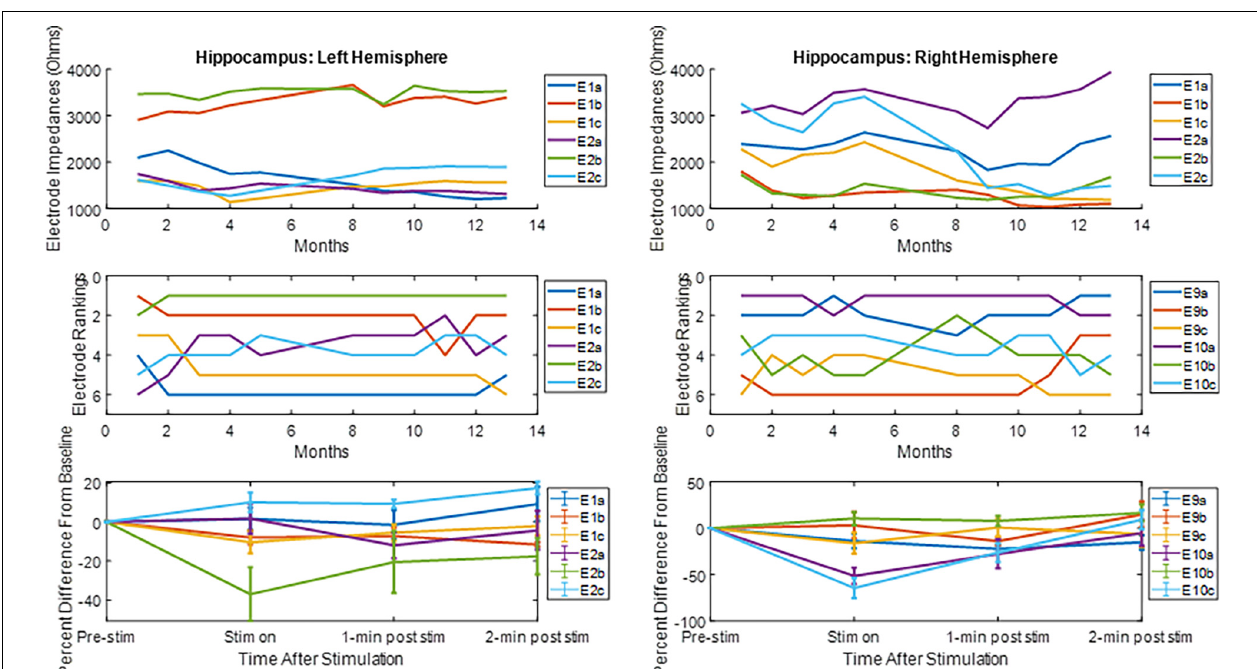
FIGURE 6 | Electrode impedance and rankings and local LFP response to hippocampal stimulation. For the electrode rankings, in-person monitors took place between months 1 and 4 and remote monitors took place between months 5 and 13. For the LFP response to stimulation, the LFP response compared to baseline is plotted for the duration of the recordings. The average response and standard error are displayed. For both hemispheres, the top-ranked electrode corresponded with an electrode that had an observable decrease in LFP activity after stimulation.